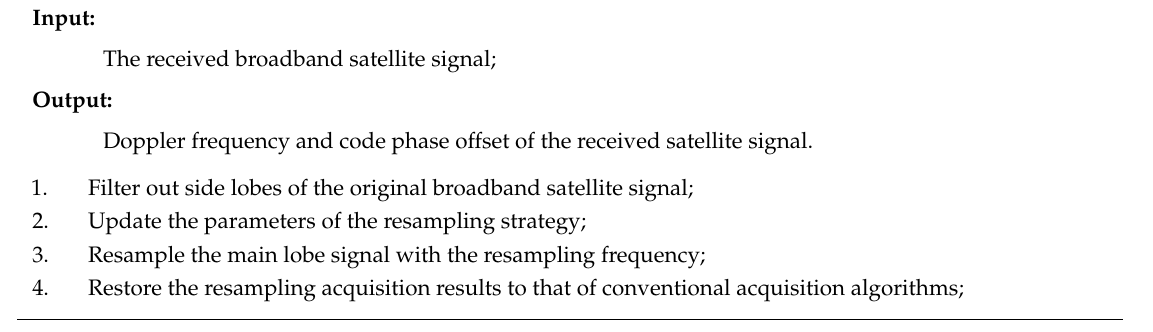
Algorithm 1 Realization of the Resampling Strategy for GNSS Signal